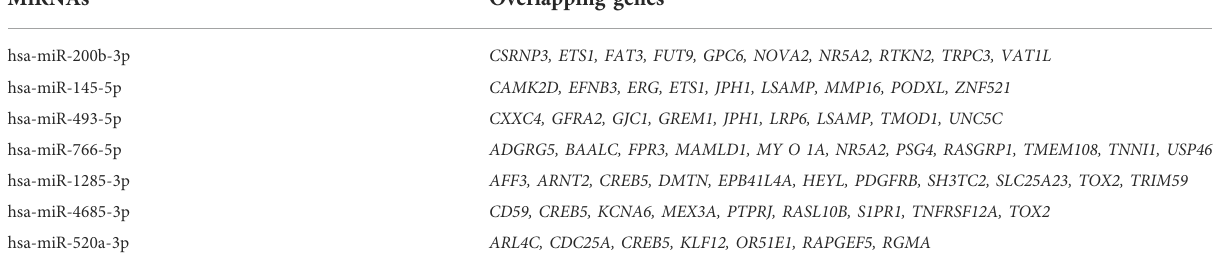
TABLE 4 Seven central differentially expressed miRNAs and target overlapping